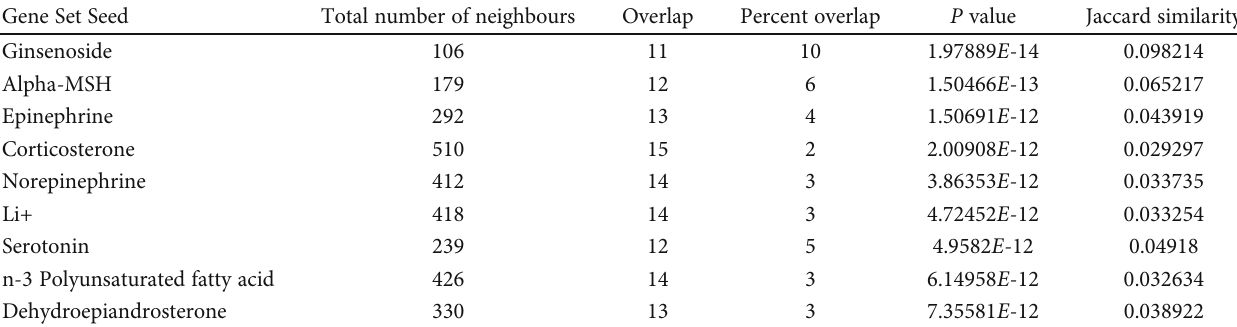
Table 3: Top 10 for compound regulators subnetworks enriched for anxiety disorder-associated genes.